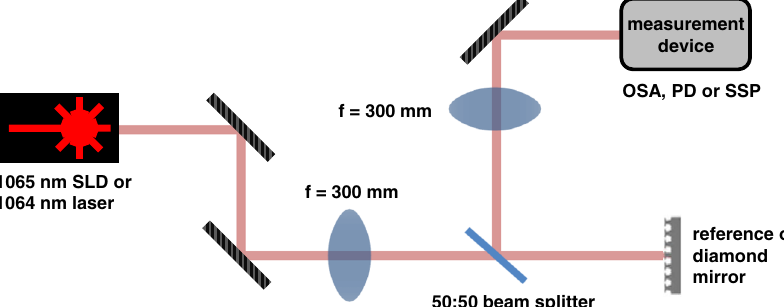
Fig. 6 Schematic of the experimental setup used for measuring the re fl ection spectrum of a diamond mirror and beam pro fi le measurements. The re fl ection spectrum is measured using light from a 1065 nm SLD that is collimated and directed with broadband silver mirrors to a 50:50 beamsplitter after passing through a focusing lens. Re fl ected light from the diamond mirror, or a reference mirror, is directed to an optical spectrum analyzer (OSA) after passing through a defocusing lens. A 1064 nm DBR laser source and free-space optical photodetector (PD) replaced the diode and OSA for the more precise re fl ectivity measurements. The PD was replaced by a scanning slit pro fi ler (SSP) for beam pro fi le measurements.